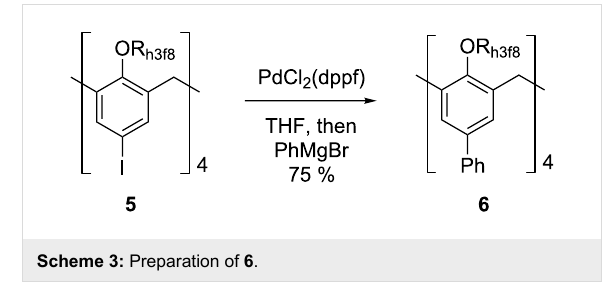
Scheme 3: Preparation of 6 .